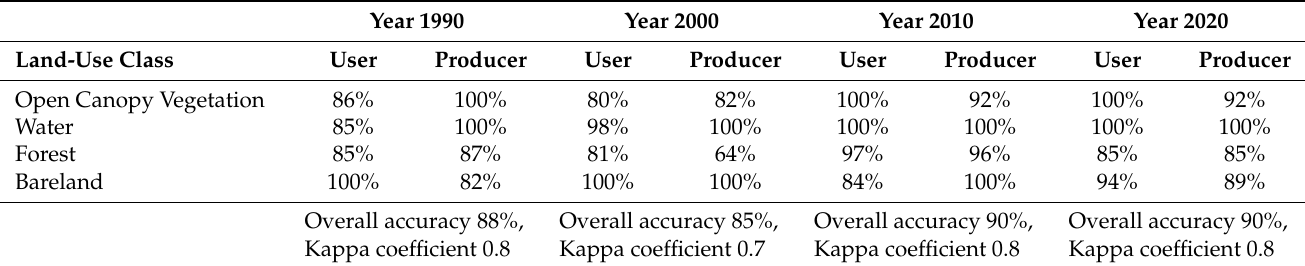
Table 3. Accuracy assessment in (%) from 1990 to 2020 land-use classification using the SVM method in the High Atlas Mountains of